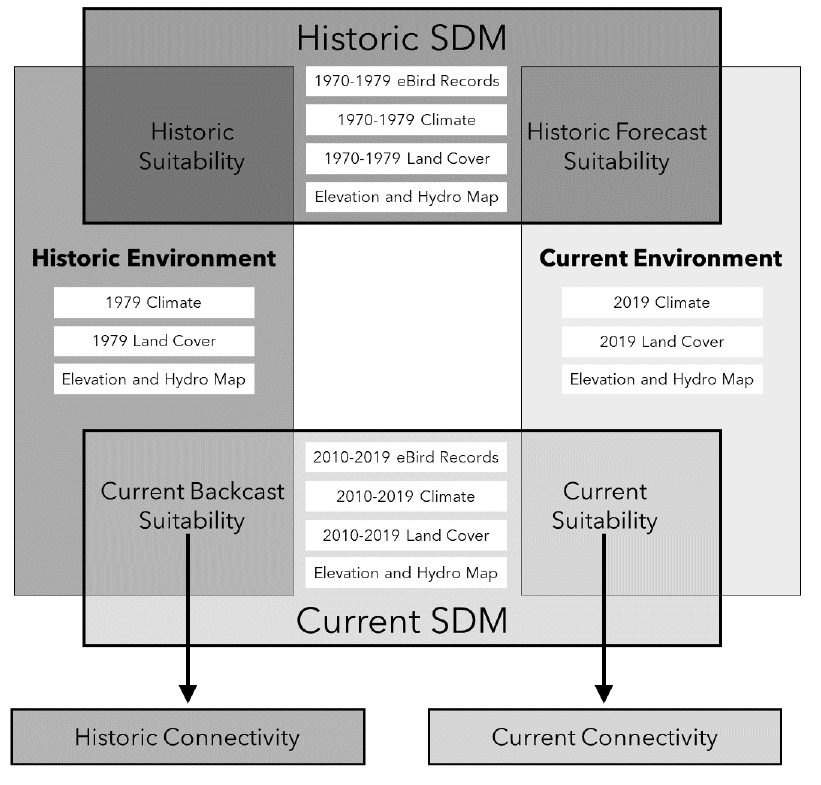
Figure 2 – Overview of modeling approach and steps. The white boxes list the data used to gener- ate the species distribution models (SDMs) and environments used for predicting habitat suitability. The overlap between shaded boxes indicates that a habitat suitability prediction was created using the overlapping species distribution model and environmental predictors. The arrows indicate the habitat suitability predictions used to create the connectivity models (see Methods for a detailed description of data sources and